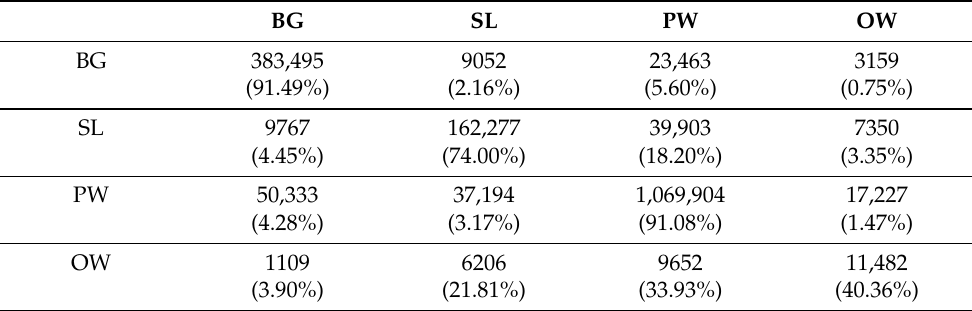
Figure 19. Representative failed Rice blast images: source images ( left ), GT ( center ), and re- sults ( right ). Table 7. Confusion matrix for Soybeans test subset images [pixels].